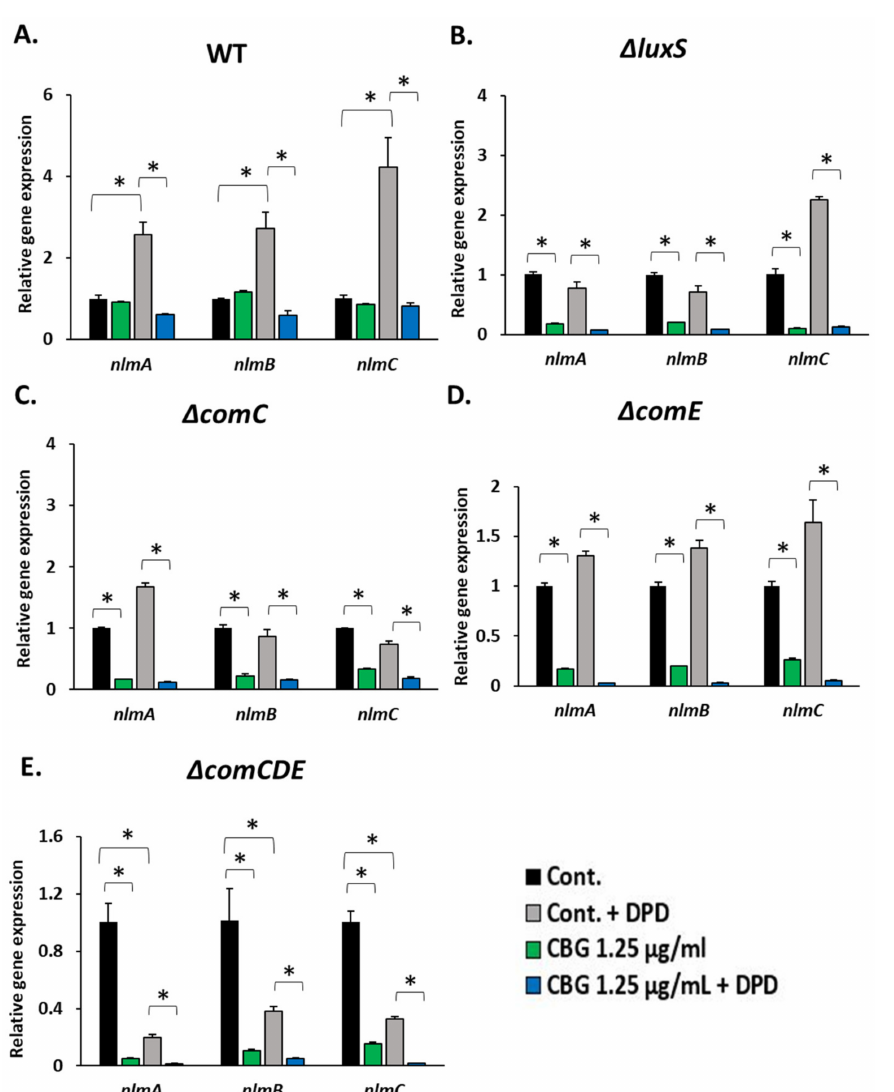
Figure 7. DPD induced the expression of the ComE-regulated genes. ( A – E ). Expression of ComE- regulated genes in various S. mutans strains incubated in the absence or presence of 1.25 µ g/mL CBG and/or 5 µ M DPD (pre-AI-2) for 4 h in comparison to control as determined by real-time PCR using respective primers. ( A ). WT; ( B ). ∆ luxS ; ( C ). ∆ comC ; ( D ). ∆ comE ; and ( E ). ∆ comCDE . n = 3; * p < 0.05.